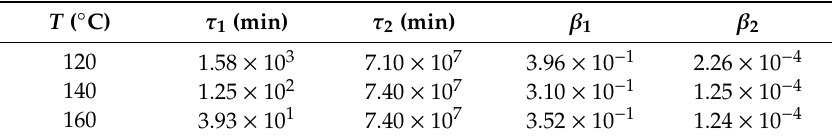
Figure 2. Left: Extent of conversion ( α ) obtained after the application of Equation (2) as a function of time. Right: Topem ® curves of c p during isothermal curing at 120, 140, and 160 °C (solid lines), and fitting data with the KWW relaxation function (dot lines). Table 1. Relaxation time ( τ ) and relaxation distribution parameter ( β ) obtained from Equation (13) for isothermal curing at 120, 140 and 160 °C.